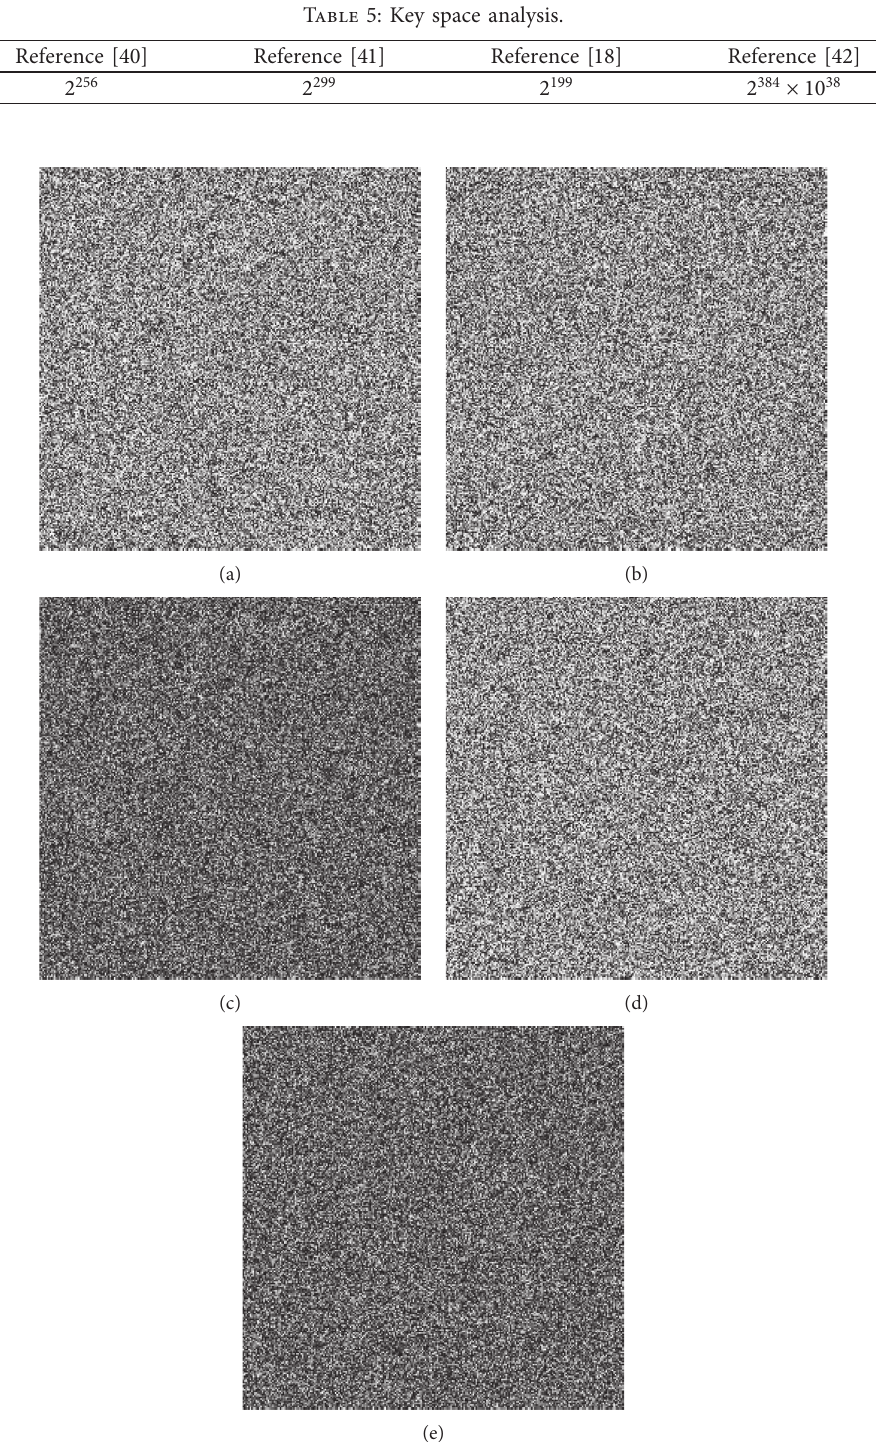
Figure 9: Encryption key sensitivity analysis: (a) the cipher image C ; (b, d) the cipher images C |( i � 1 , 2 ) . | C − C i